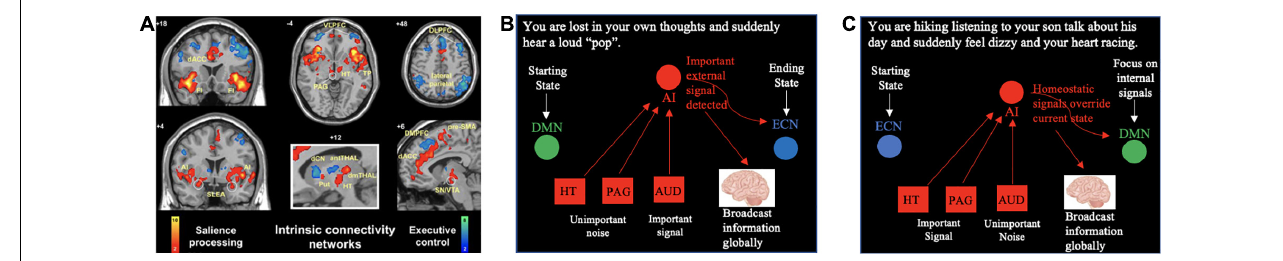
FIGURE 2 | The SN monitors input from all different brain centers to respond to our shifting internal and external (environmental) states. (A) The first study of the “salience network” identified several subcortical hubs of the network including the amygdala (conveying information about threats and fear responses), the hypothalamus (conveying information about bodily homeostasis), and the periaqueductal gray (conveying information about pain). Adapted from Seeley et al. (2007) (Copyright 2007, Society for Neuroscience). (B,C) Depict two different scenarios in which the salience network monitors incoming information and reorients our attention in response to our shifting environments or shifting thoughts. AI, anterior insula; antTHAL, anterior thalamus; AUD, auditory processing centers; ECN, executive control network; dCN, dorsal caudate nucleus; DMN, default mode network; dmTHAL, dorsomedial thalamus; DMPFC, dorsomedial prefrontal cortex; HT, hypothalamus; PAG, periaqueductal gray; Put, putamen; SLEA, sublenticular extended amygdala; SN/VTA, substantia nigra/ventral tegmental area; TP, temporal pole; VLPFC, ventrolateral prefrontal